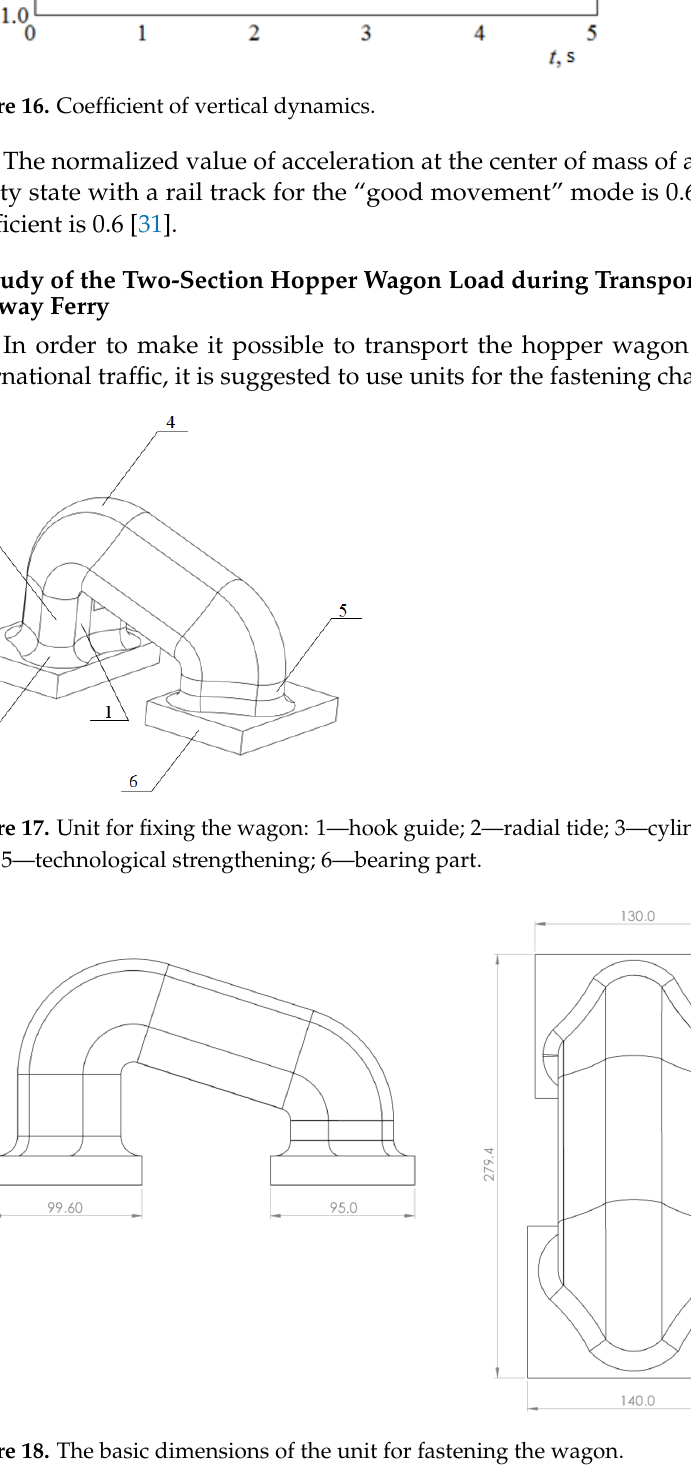
Figure 16. Coefficient of vertical dynamics.